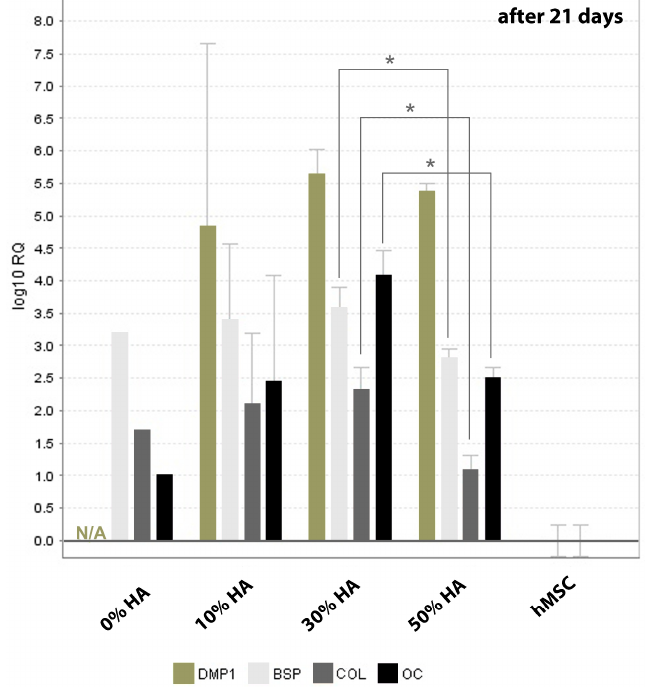
Figure 4. Relative expression (RQ) of osteogenic markers after 21 days of dynamic human mesenchymal stem cells (hMSCs) culture. The relative gene expression was analyzed by comparative cycle threshold method ( ∆∆ Ct) and the values were normalized to β -actin expression. Significant difference between two groups ( p < 0.05) is designated as (*).